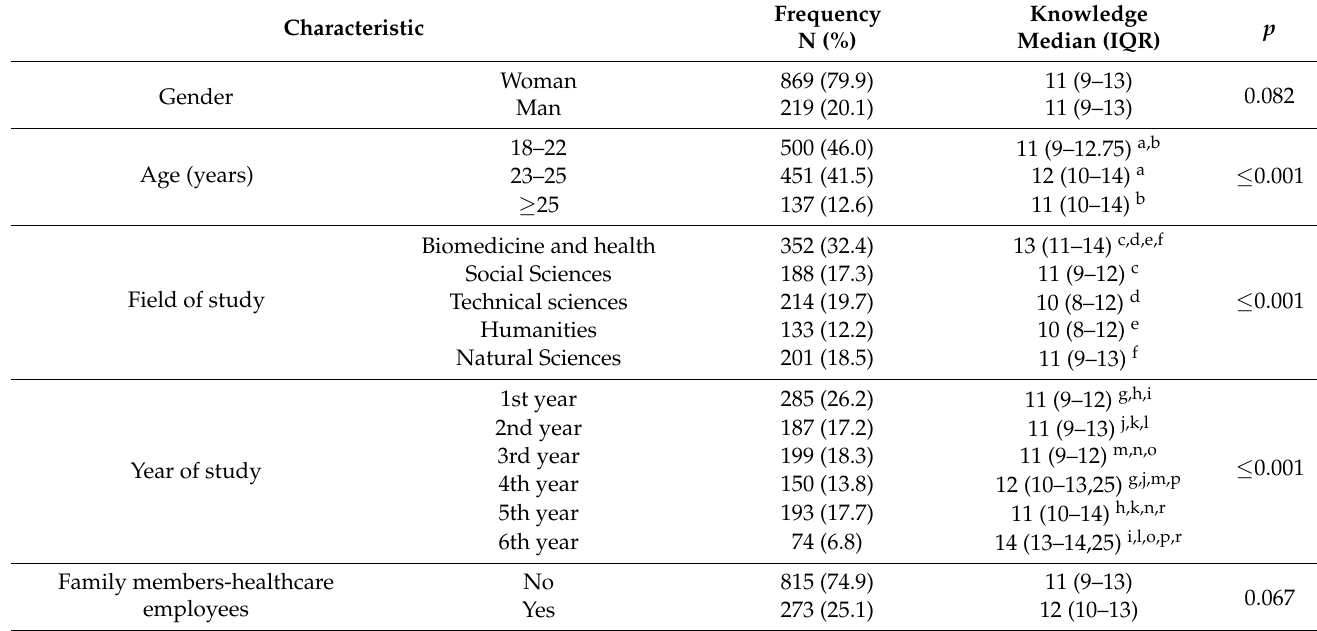
Table 1. Demographic characteristics of students according to the average assessment of knowledge about oral